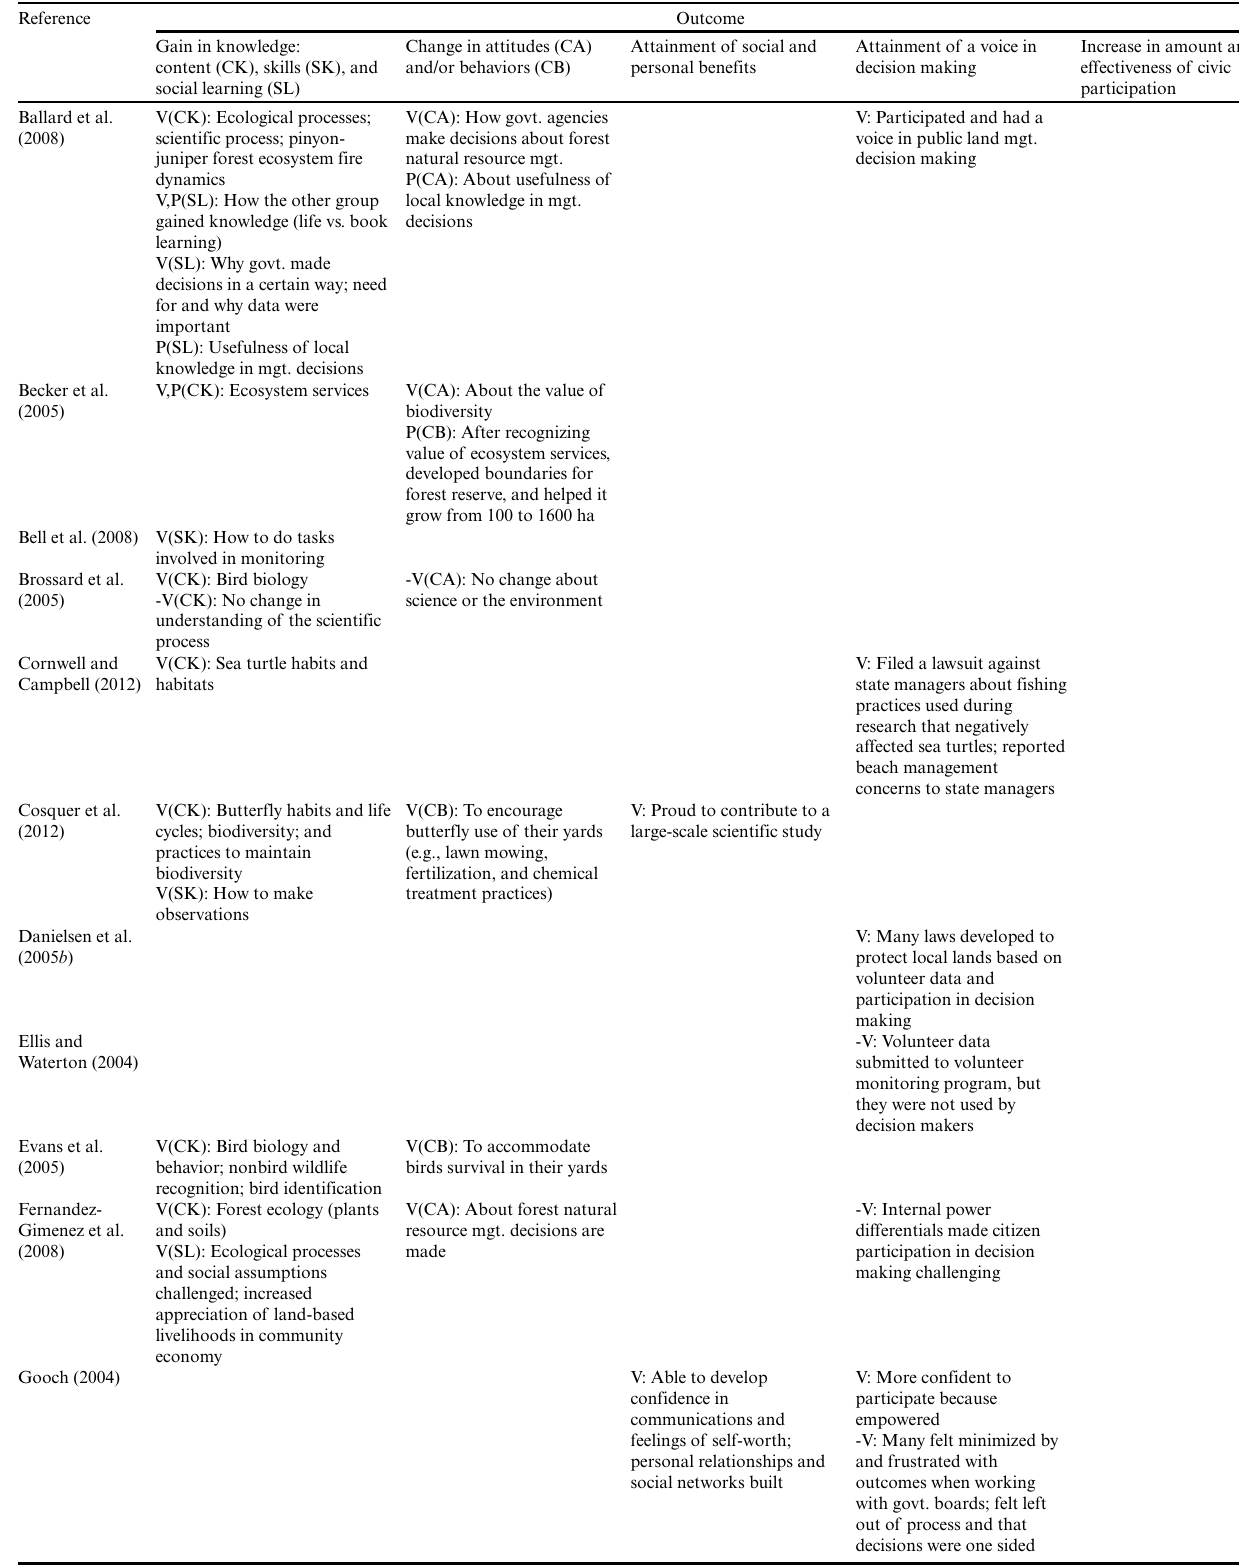
Table 4 . Outcomes of volunteer environmental monitoring for individuals reported in peer-reviewed literature through 2012. Outcomes were reported for both volunteers (V) and professionals (P) involved in volunteer monitoring efforts. Null or negative outcomes were sometimes reported